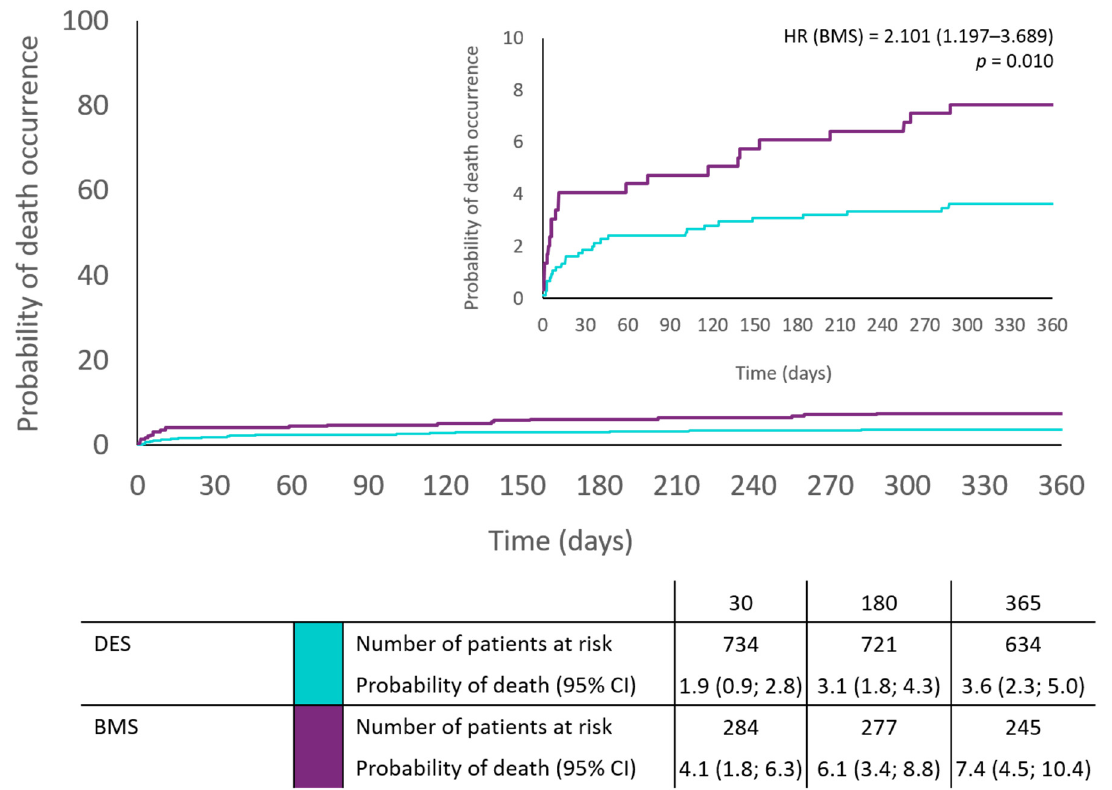
Figure 1. Kaplan-Meier curves of cumulative incidence of death during 365 days in DES and BMS group. Compared to DES, the rate of confirmed stent thrombosis in BVS was comparable at 30 days (1.5% vs. 0.8%, HR: 1.89; 95% CI: 0.22 to 15.75; p = 0.553), and at 365